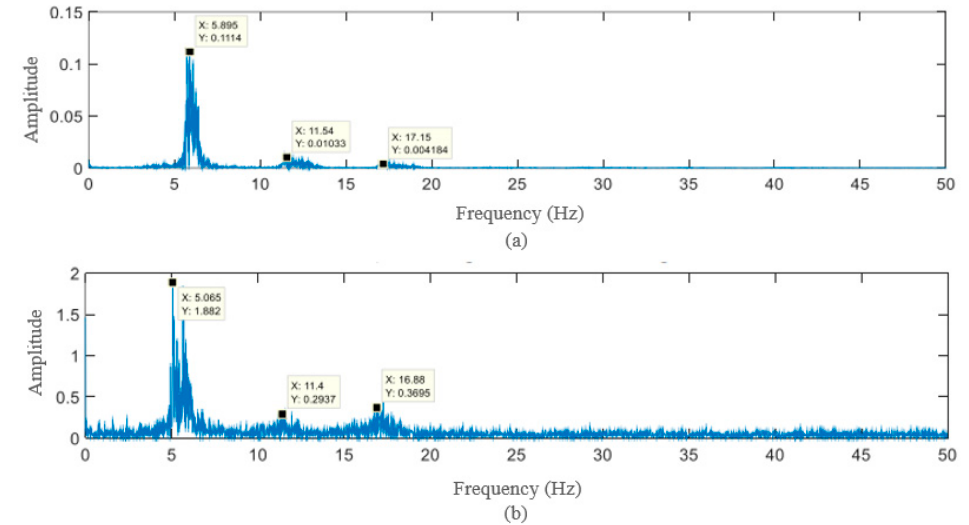
Figure 2. Analysis of a frequency range of tremors from patients g2 ( a ) and g9 ( b ).